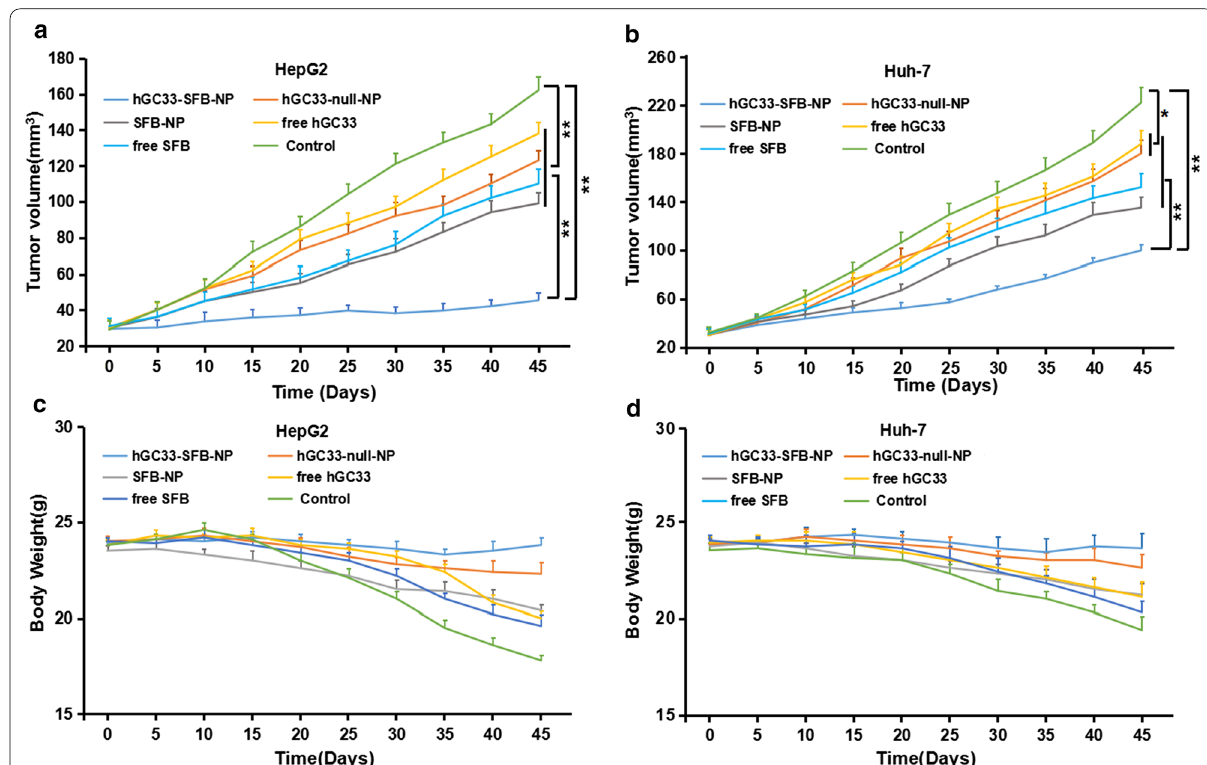
Fig. 9 The effect of hGC33-SFB-NP on xenotransplantation of HCC in nude mice and the changes of mice weight. Liver cancer cells were inoculated subcutaneously on the back of each nude mouse ( n 10). After 10 days, the tumor bearing mice were treated with PBS (control), free hGC33, free = SFB, hGC33-null-NP, SFB-NP, and hGC33-SFB-NP. Tumor size ( a , b ) and body weight ( c , d ) of mice were monitored at designated time